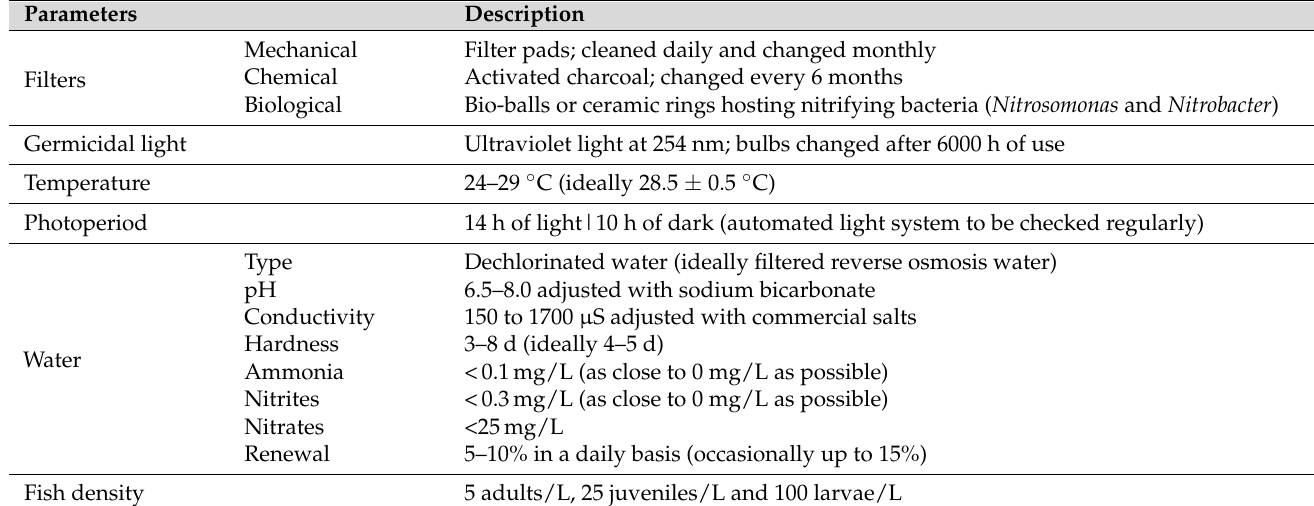
Table 1. Optimal parameters to standardize zebrafish housing conditions according to refs.